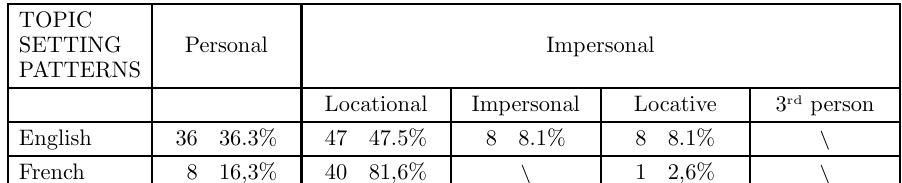
Topic setting patterns TOPIC SETTING Personal Impersonal PATTERNS